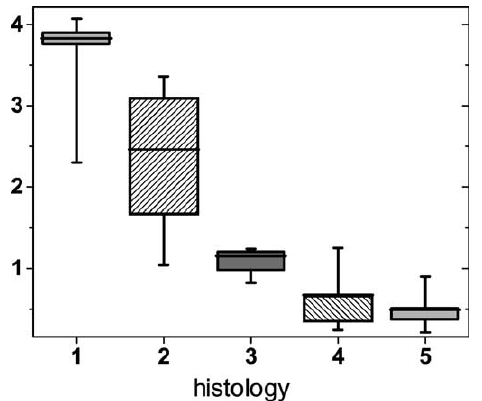
Fig. 3. Mean “total number of AgNORs/nucleus” of the patients ac- cording to the WHO type: 1 – Burkitt and lymphoblastic